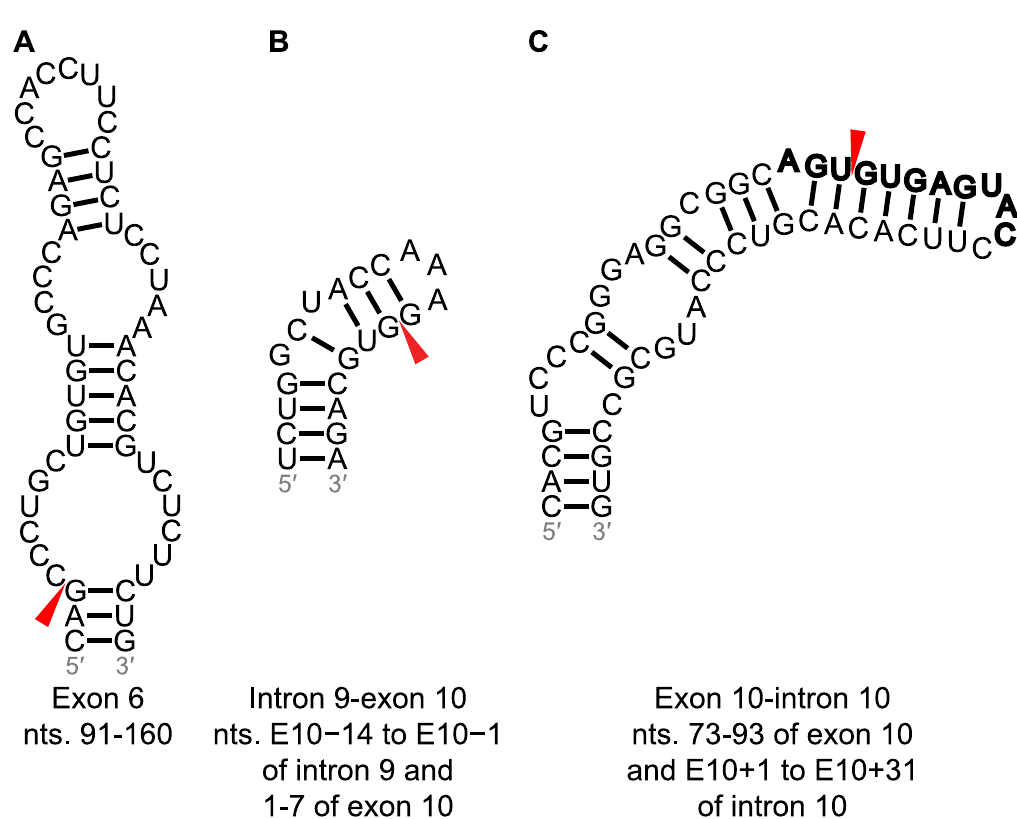
Fig 3. Predicted structures at alternatively-spliced exon-intron junctions. Splice sites are denoted with red arrowheads. Potential U1 snRNA binding sites are denoted by bold nucleotides. The enhancer in the hairpin structure at the exon 3-intron 3 junction is colored orange. Usage note: at a 3 0 splice site, intronic nucleotides are denoted by a minus ( − ) sign and their position upstream of the adjacent exon, while exonic nucleotides are denoted by their position relative to the first nucleotide of the exon. At a 5 0 splice site, intronic nucleotides are denoted by a (+) sign and their position downstream of the adjacent exon.